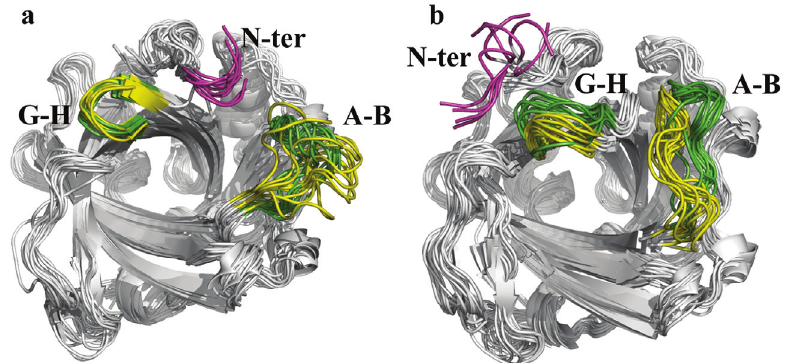
Figure 7. Structural analysis of MD sampled snapshots. Superposition of the snapshots taken every 10 ns from the MD trajectories sampled for the ( a ) open and ( b ) closed states of wild type NP7 and its Δ (1-3) variant. The backbone of the extra Leu-Pro-Gly stretch found in NP7 is shown in magenta, and the backbone of the A-B and G-H loops for wild type and Δ (1-3) NP7 is shown in green and yellow,